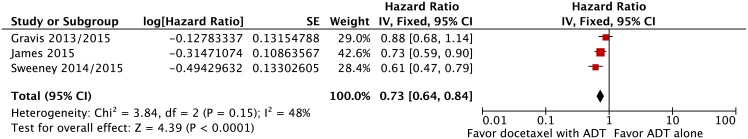
Comparative effect in overall survival of ADT with docetaxel versus ADT alone (Fixed-effect model analysis).Abbreviations: ADT, androgen-deprivation therapy; CI, confidence interval.